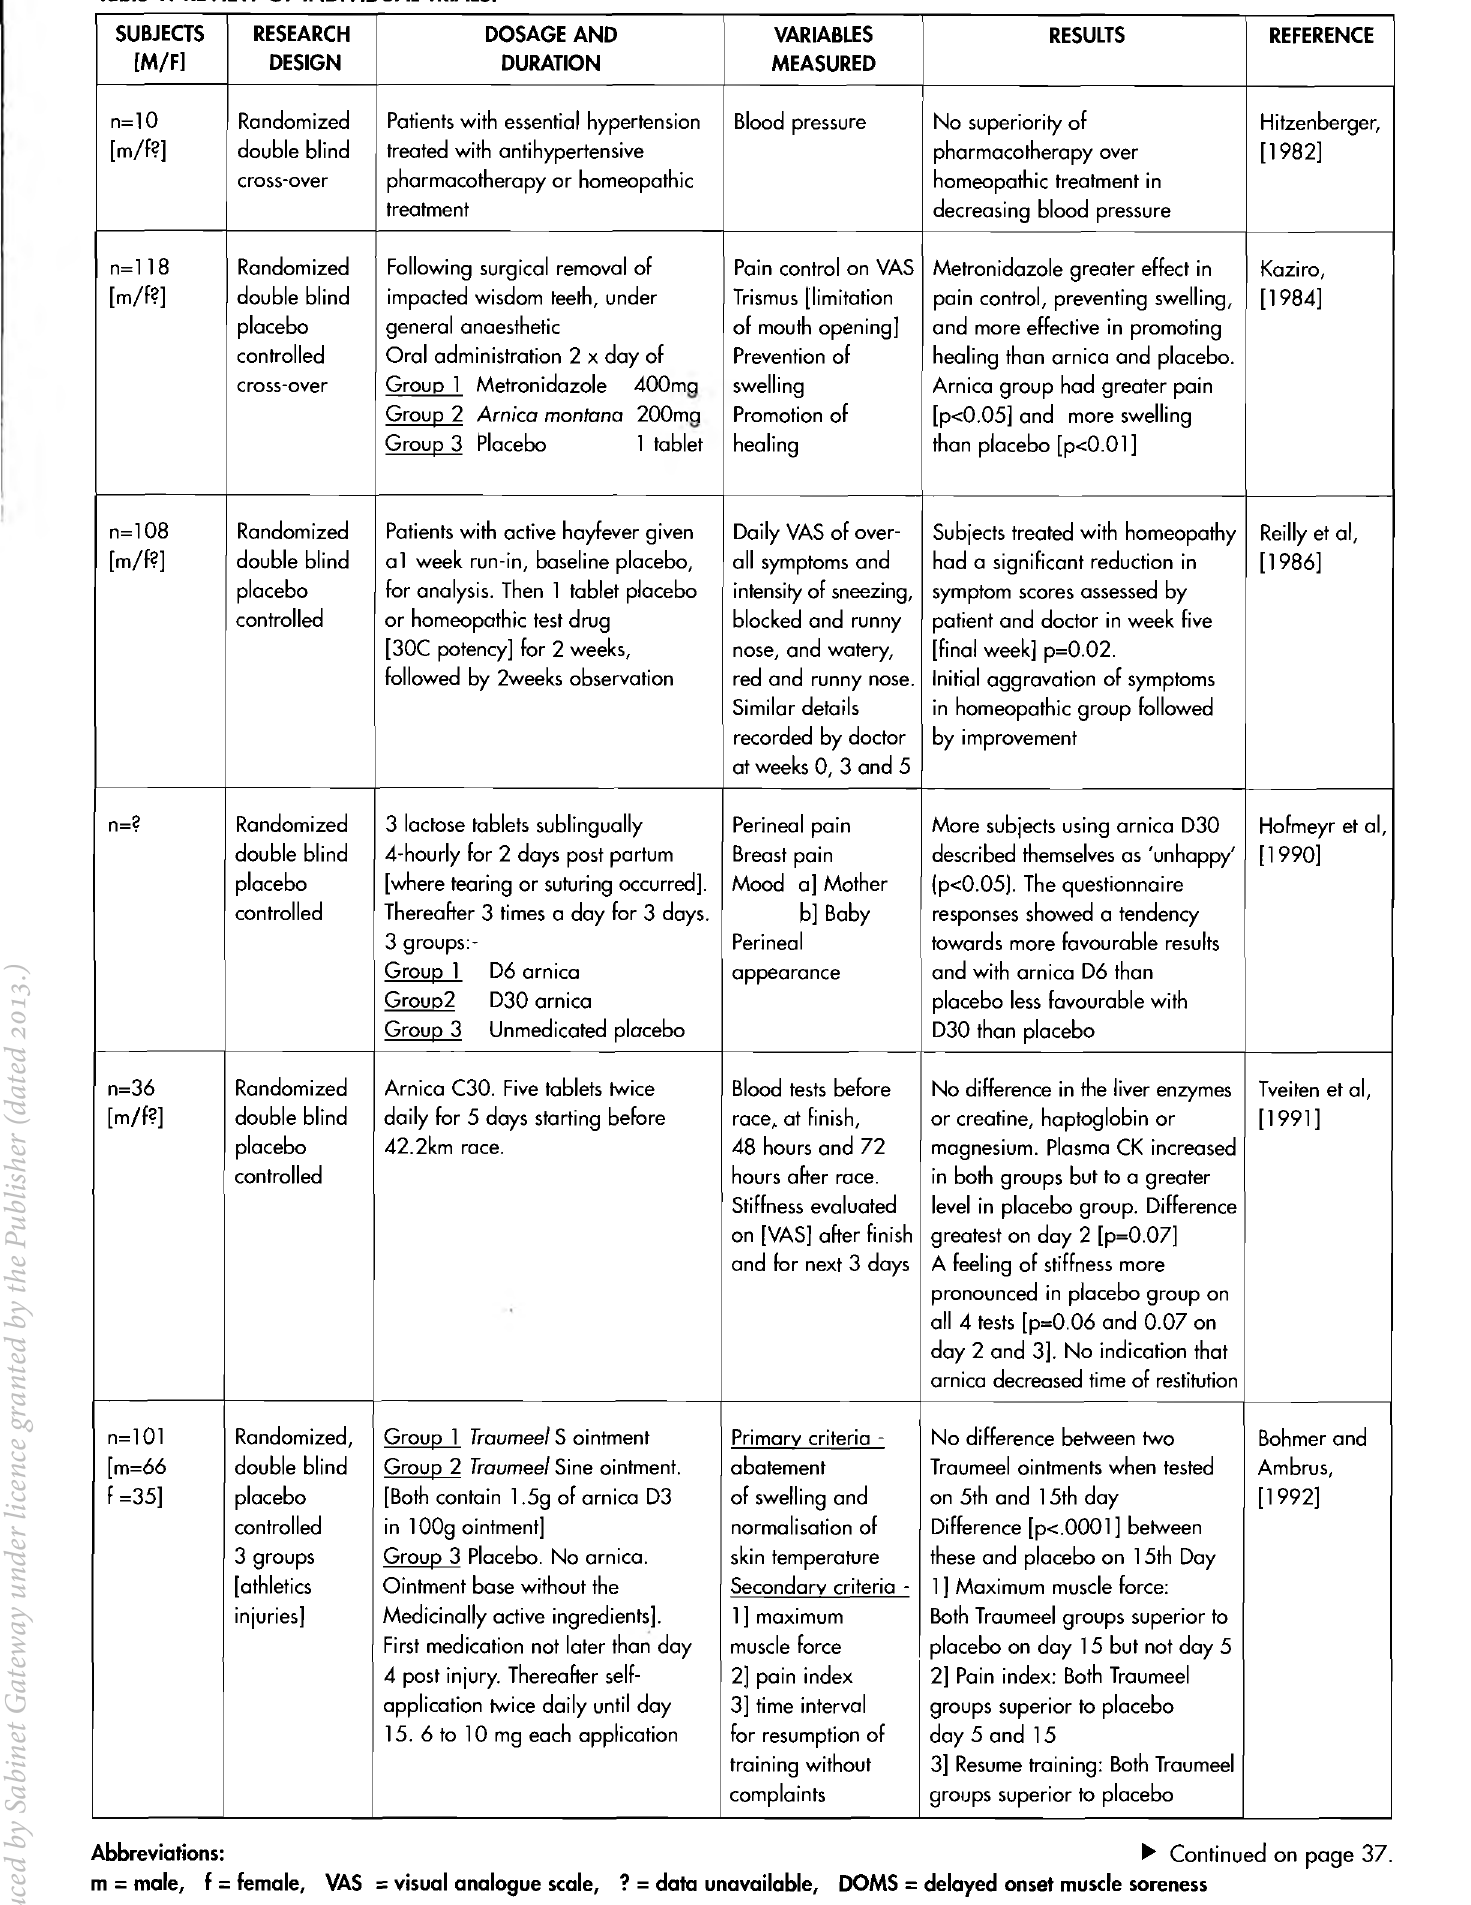
Table 1: REVIEW OF INDIVIDUAL